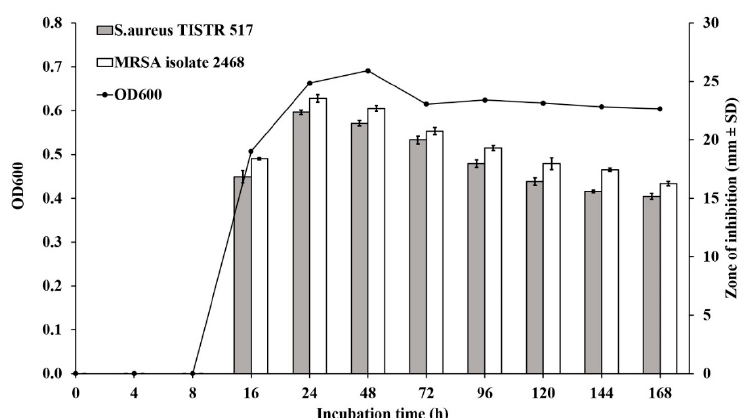
Figure 2. The growth curve and production kinetics of anti-MRSA substances from Brevibacillus sp. SPR-20. The growth curve was measured at optical density (OD) 600 nm, while the antibacterial activity against S. aureus TISTR 517 and MRSA isolate 2468 was determined by the zone of inhibition using the agar well diffusion technique. The experiments were performed in triplicate, and the results are expressed as mean ± SD.